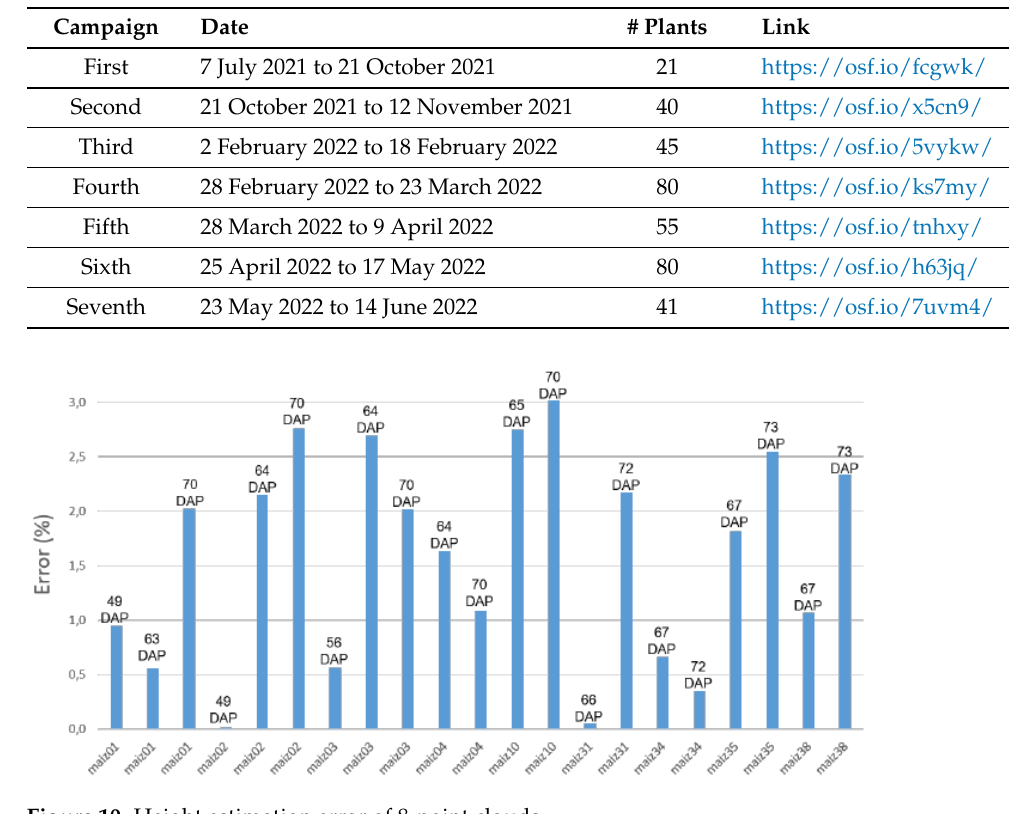
Figure 10. Height estimation error of 8-point clouds. Table 4. Estimation of the volume of a seedling in its different temporal